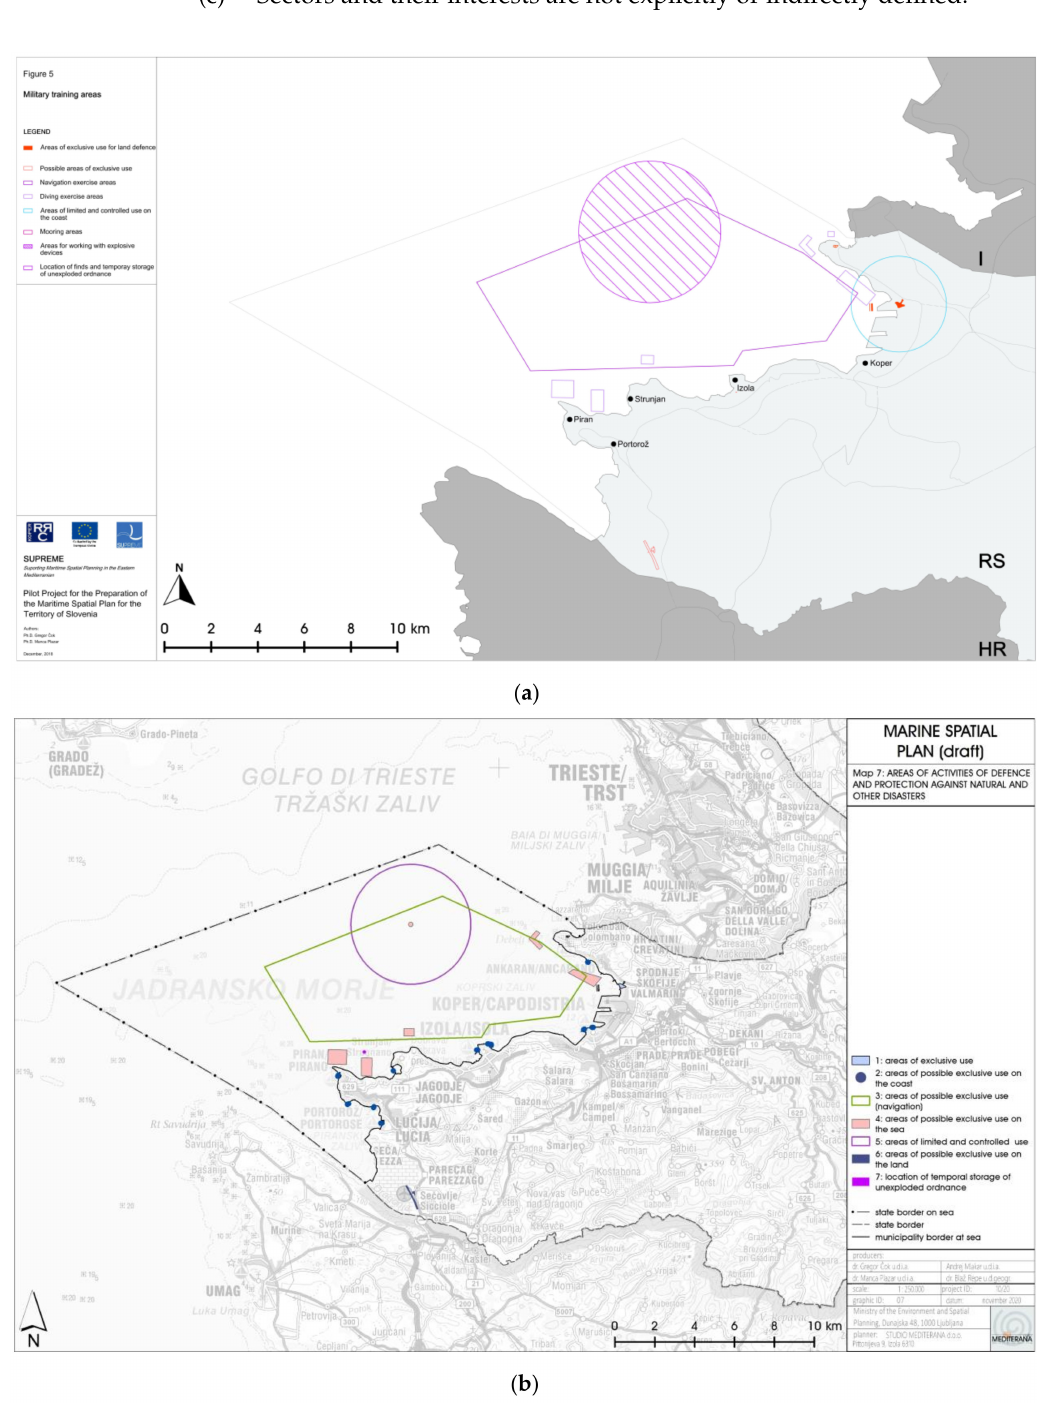
Figure 2. Identification of military training areas: SUPREME [63] ( a ) and draft plan [68] ( b ). The figures illustrate high coherence between the SUPREME project and the draft